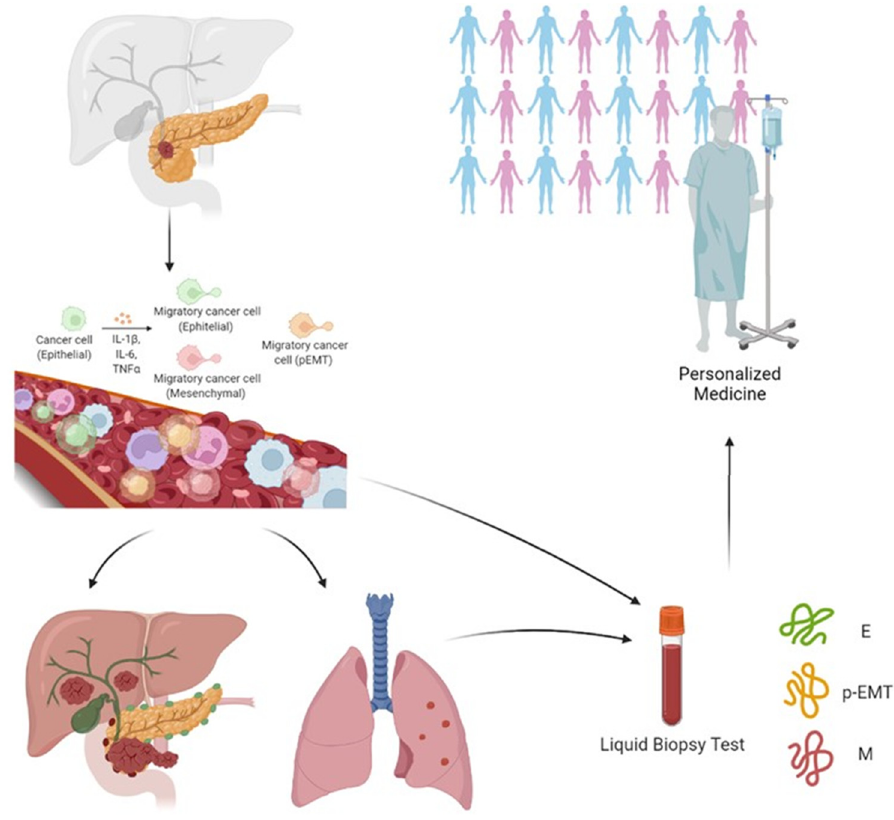
Figure 2. The presence in the blood of EMT markers from pancreatic cancer migratory cell (CTC), epithelial (E-CTC), mesenchymal (M-CTC) and/or hybrid population expressing both epithelial- and mesenchymal-specific genes (E/M-CTC or partial EMT cells) could represent great potential for anticipating PDAC detection, possibly providing a new tool for personalized medicine. Created with BioRender.com (accessed on 10 June 2022).